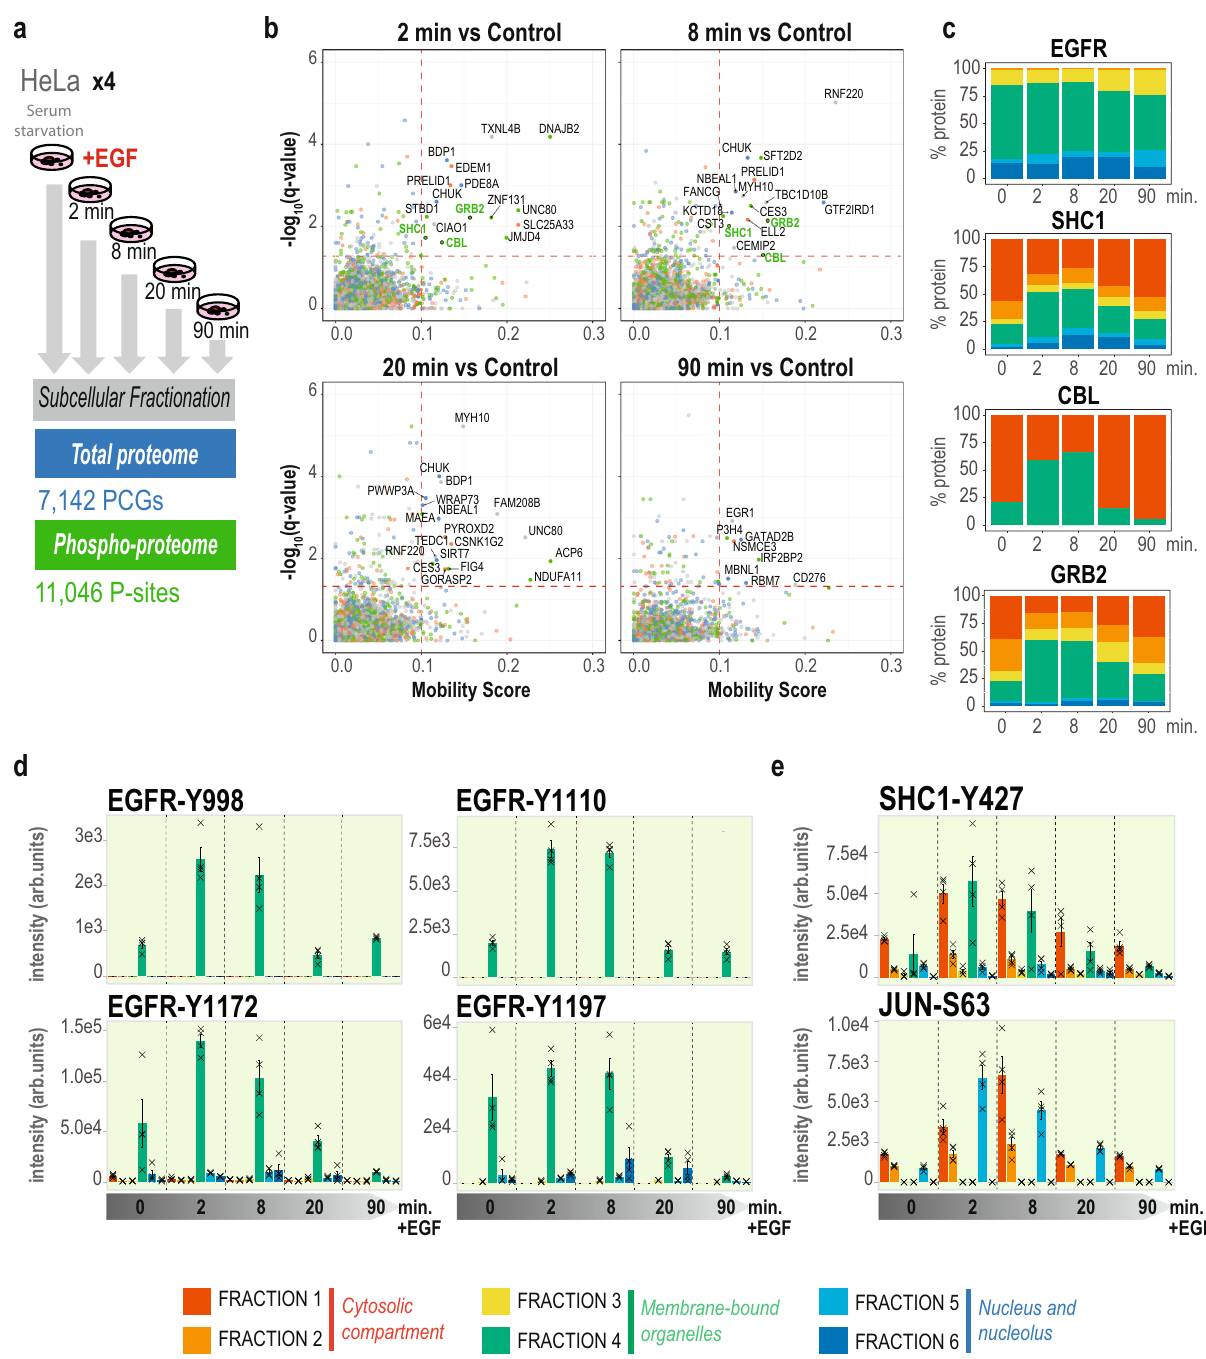
Fig. 4 Spatio-temporal phosphoproteomics in response to EGF stimulation. a Experimental design and result overview with number of proteins and phosphorylation-sites (p-sites) obtained from the subcellular fractionation of HeLa cells treated with EGF at different time points. PCGs: Protein Coding Genes. b Translocation plots of EGF treated samples at 2, 8, 20, and 90 min versus control. Red dashed lines indicate the cutoff threshold used for mobility score and signi fi cance levels. The color of the dots indicate which compartments the proteins are moving to and from. Compartment are grouped as three: cytosol (FR1 and FR2), membrane-bound organelles (FR3 and FR4) and nuclear compartment (FR5 and FR6). Red: nuclear compartment to/from membrane-bound organelles. Green: cytosol to/from membrane-bound organelles. Blue: nuclear compartment to/from cytosol. Grey: proteins moving within same compartment. GRB2, SHC1 and CBL are highlighted in green. c Stacked bar-plot of scaled protein intensities across fractions and time points of EGFR and adaptor proteins CBL, SHC1, and GRB2. d Bar-plot of intensities across fractions and time points of EGFR tyrosine phosphorylation sites. A cross represents each independent measurement. Height of the bars represents the mean intensity of n = 4 measurements of the protein, and error bars represent the standard error of the mean. e Bar-plot of intensities phosphorylation sites across fractions and time points of SHC1 and JUN. A cross represents each independent measurement. Height of the bars represents the mean intensity of n = 4 measurements of the protein, and error bars represent the standard error of the mean. Source Data for Figs. 4c, d, and e are provided as a Source Data fi